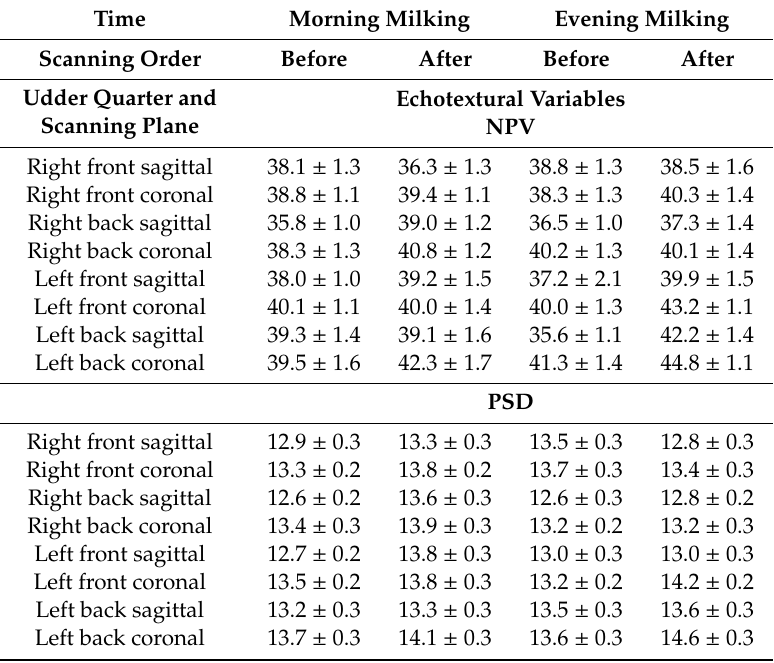
Table 4. A breakdown of the echotextural characteristics of the udder parenchyma (mean ± SEM) determinedwithcomputer-assistedanalysesofmammaryglandultrasonogramsfrom30Holstein-Friesian cows examined before and after complete mechanical milking in the morning and evening. NPV: Numerical pixel values (0–255); PSD: Pixel standard deviation or pixel heterogeneity. See text for details of statistical comparisons.